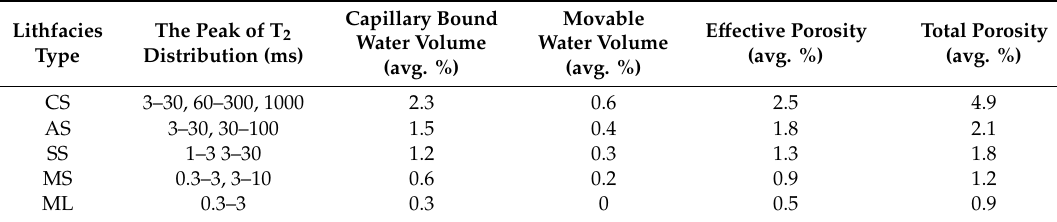
Table 2. The reservoir evaluation results of five types of shale lithofacies in the Da’anzhai member from NMR well logging